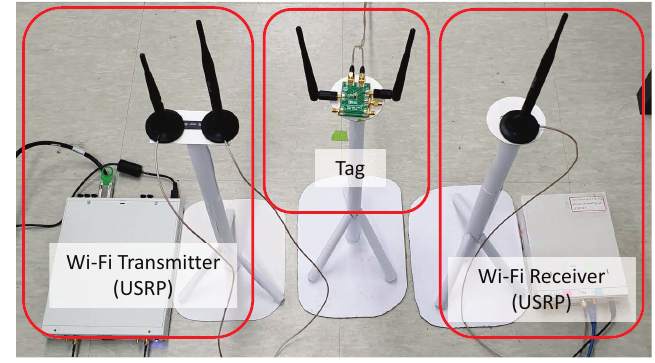
Figure 6. Experimental setup.